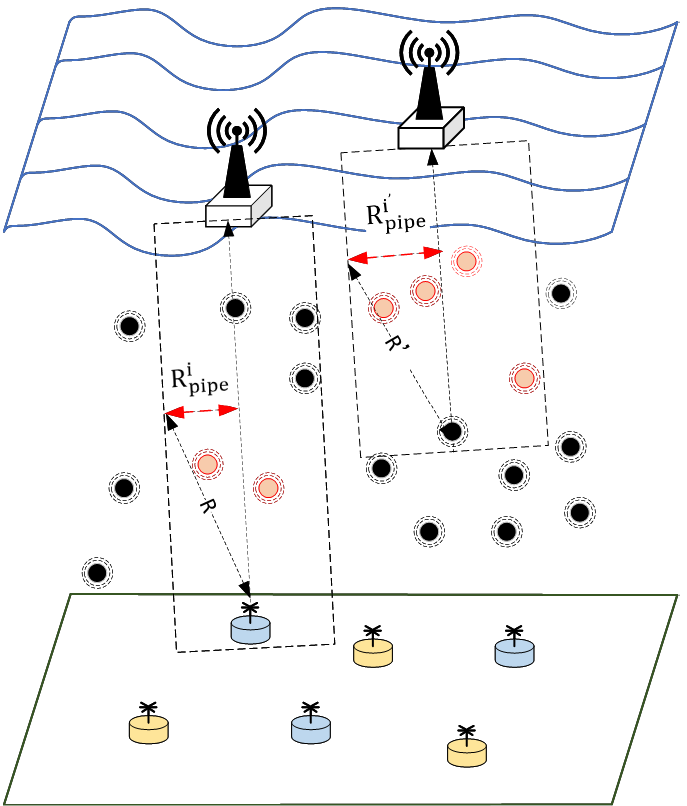
Figure 5. Schematic diagram of virtual pipeline. The candidate relay nodes in the virtual pipeline are represented in red, and the color of the sensor nodes represents the type of collected data.